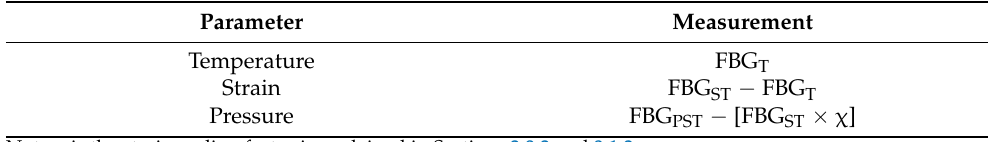
Table 1. Parameters monitored and the corresponding FBG measured (used in in conjunction with Equations (3) and